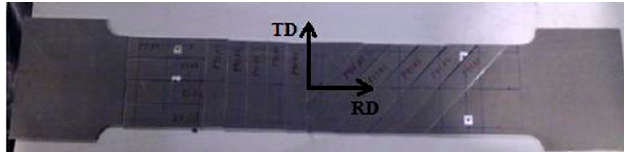
Figure 2. Pre-loaded sample ready for cutting into small samples (RD—rolling direction; TD— transverse direction).